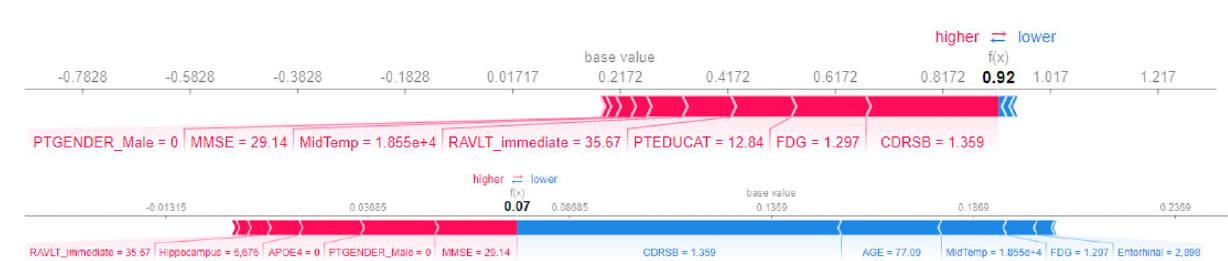
Figure 21. Comparison between features impact on the predicted (EMCI) and true class (SMC) of a subject.